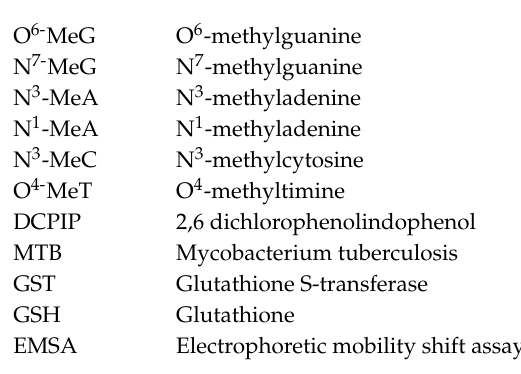
Figure S1: Ada and Ogt protein models; Figure S2: MALDI-MS spectrum. MALDI-MS spectrum of the Random oligonucleotide probe in the linear mode showing the expected mass value (7632.21 Da). Table S1: Peptide mapping of the GST-Ogt fused protein by MALDI-TOF; Table S2: Peptide mapping of the GST- Ada-AlkA fused protein by MALDI-TOF; Table S3: Oligonucleotide probes used in the EMSA experiments; Table S4: Peptide mapping of the FadE8 protein by